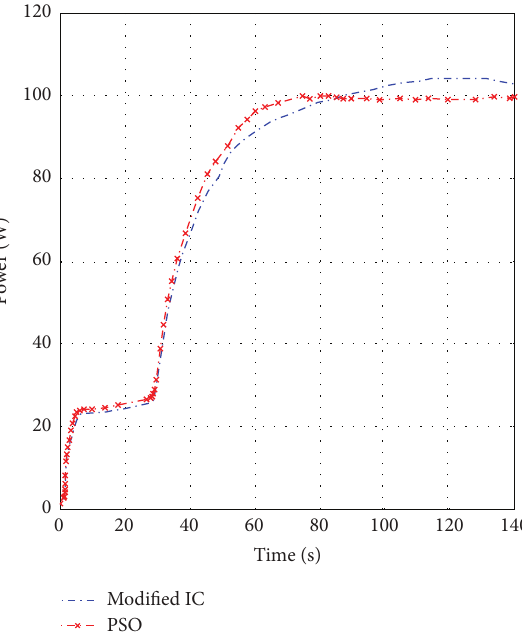
Figure 10: Comparison of proposed MPPT and conventional IC for daily Malaysian